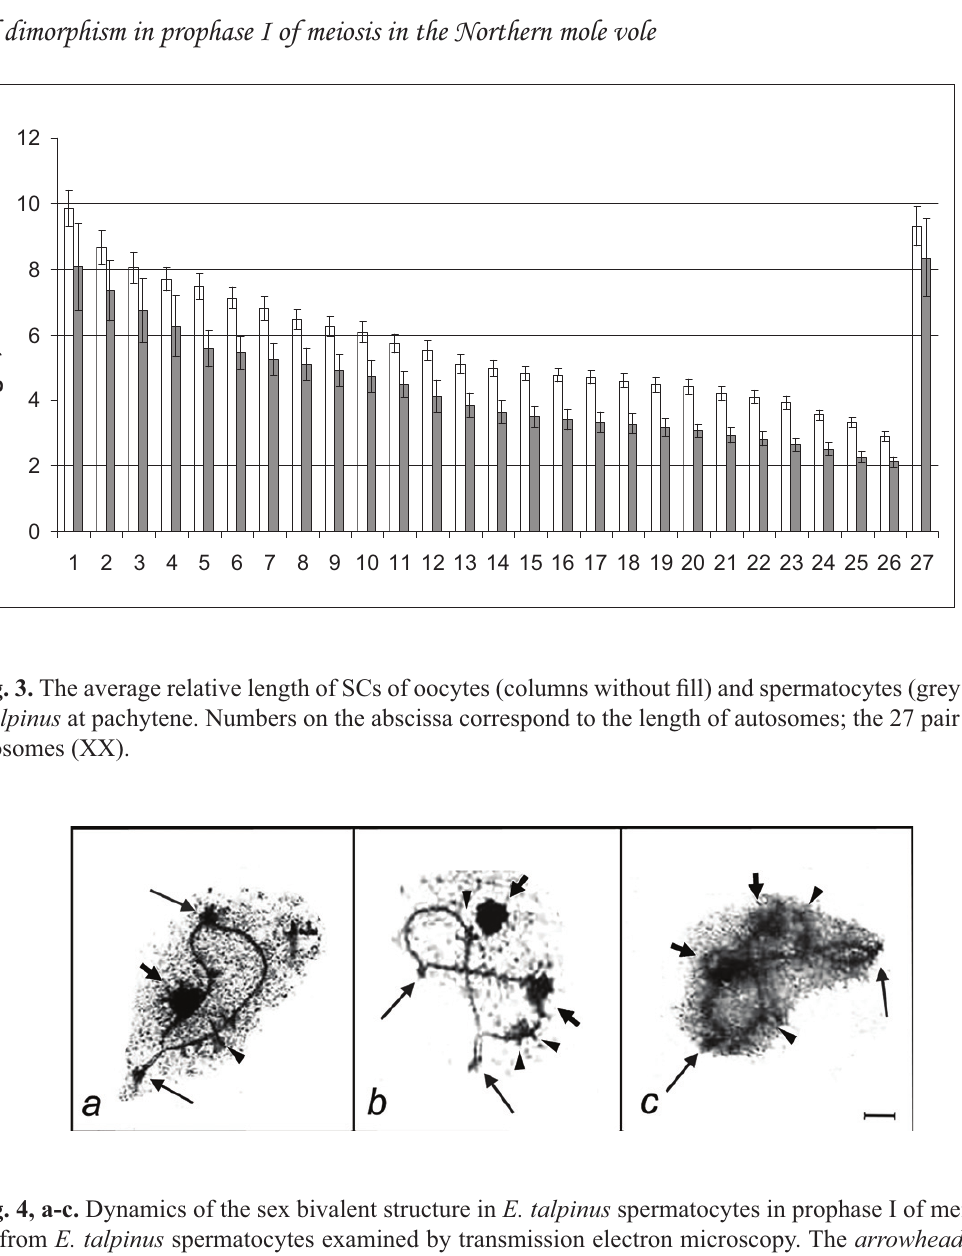
Fig. 4, a-c. Dynamics of the sex bivalent structure in E. talpinus spermatocytes in prophase I of meiosis. SCs spread from E. talpinus spermatocytes examined by transmission electron microscopy. The arrowhead indicates thorns on axes. The short arrow indicates the electron-dense nucleolus-like body; the long arrows indicate short paratelomeric SC fragments. Bar = 1 μm. a - late zygotene. A closed sex bivalent with short paratelomeric SC fragments and extensive zone of asynapsis between the axial elements of XX chromosomes. b - pachytene. Two electron-dense nucleolus-like bodies at each of XX chromosomes axes. c - diplotene. The compact sex bivalent has a complicated confi guration and is surrounded by a “cloud” of electron-dense